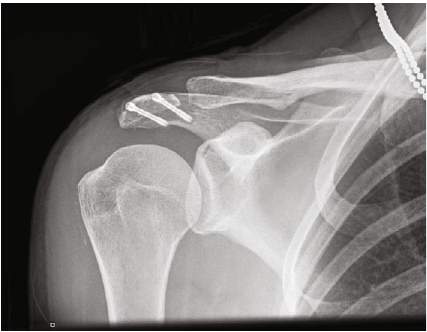
Figure 4: Postoperative radiograph of the fi nal position of the